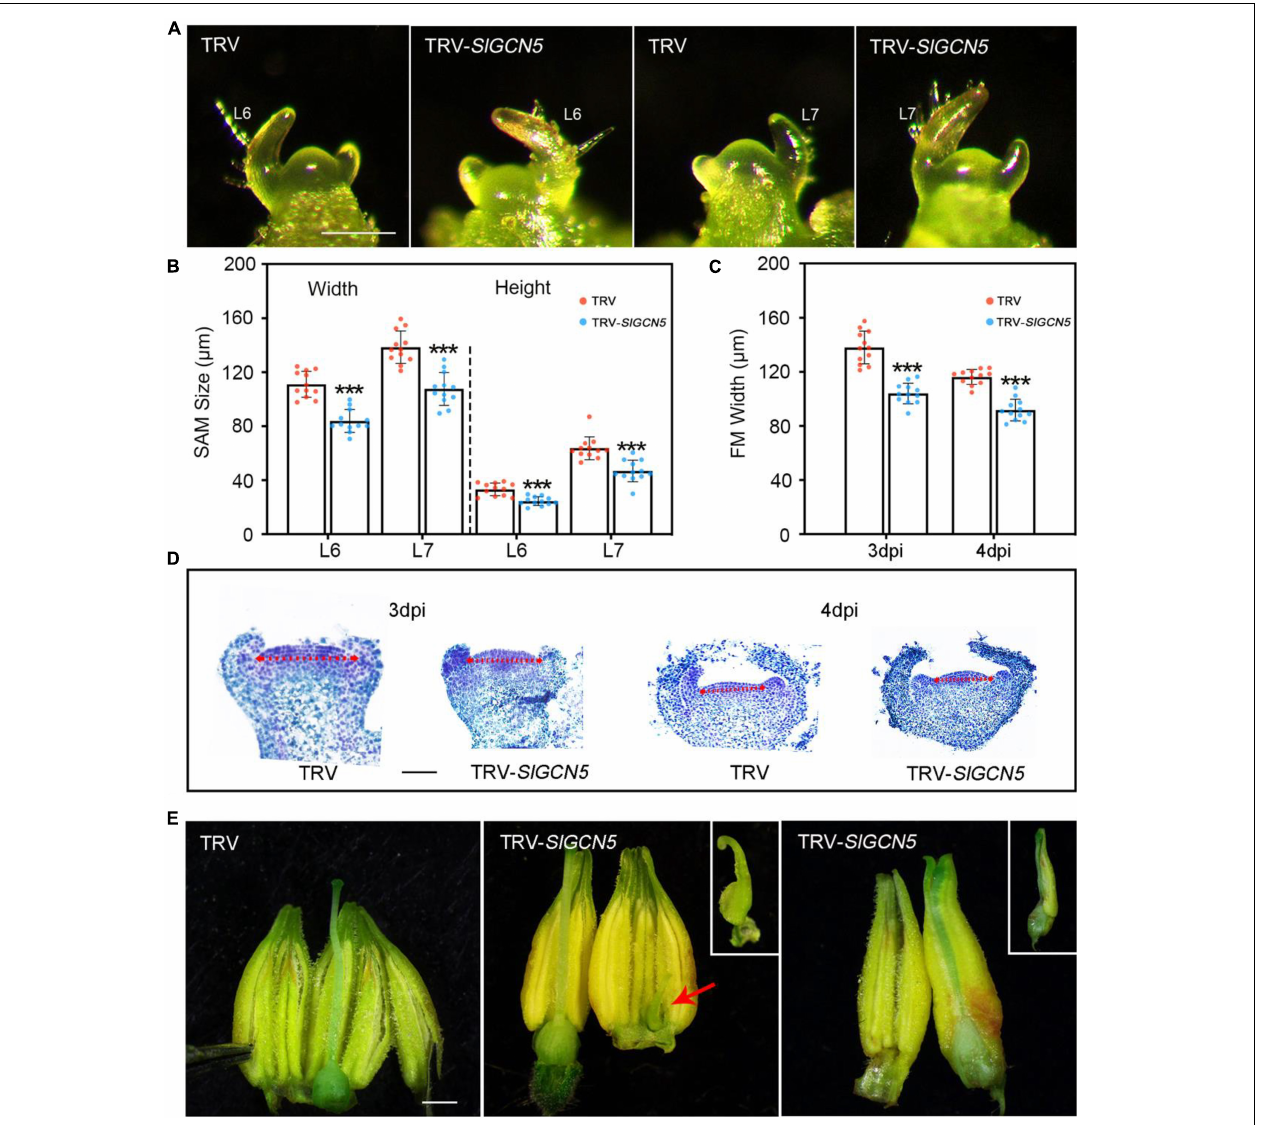
FIGURE 4 | SAM and floral phenotype of silenced- SlGCN5 plants. (A) Images of the SAMs from TRV control and TRV- SlGCN5 plants. L6 and L7 indicate Leaf 6 and Leaf 7, respectively. Scale bars = 200 µ m. (B) SAM size from TRV control and TRV- SlGCN5 plants. Error bar indicates SD of 12 biological replicates. (C) FM size from TRV control and TRV- SlGCN5 plants at 3 and 4 dpi (days post floral initiation). Error bar indicates SD of 12 biological replicates. (D) Longitudinal sections of floral meristem of TRV control and TRV- SlGCN5 plants. The red dash arrow marks the width of each floral meristem. Scale bars = 50 µ m. (E) Flowers of TRV and TRV- SlGCN5 . Scale bars = 1 mm. Asterisks indicate significant differences between TRV control and TRV-SlGCN5 (*** p <